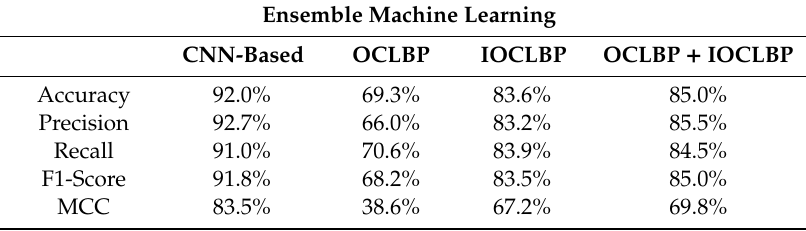
Table 6. Comparative analysis of non-handcrafted and handcrafted features classification. Metrics are for the test dataset.